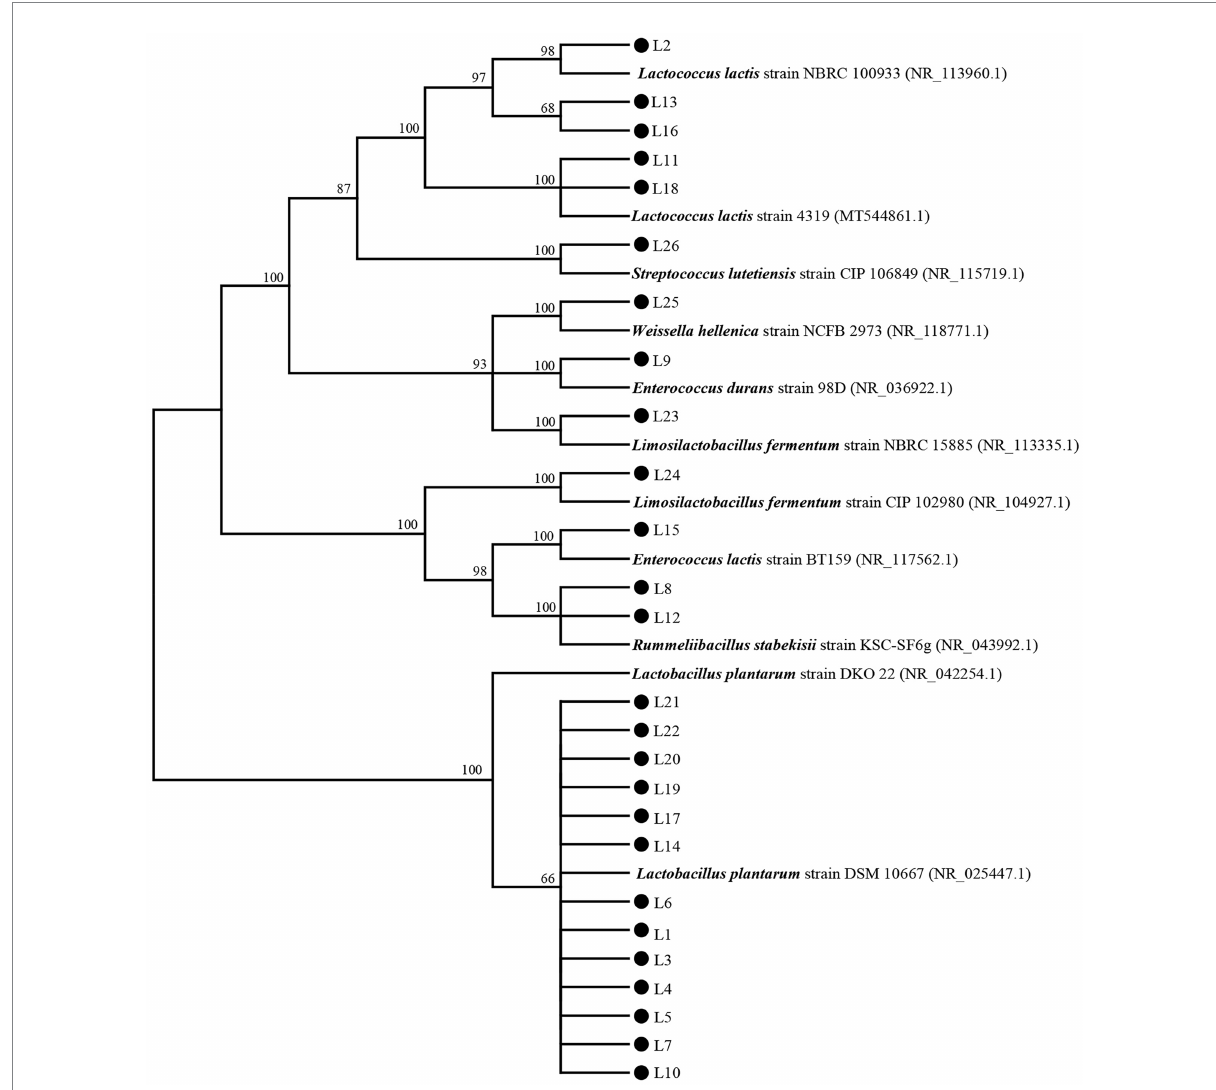
FIGURE 1 The phylogenetic tree based on 16S rDNA genes of the 26 isolates and type